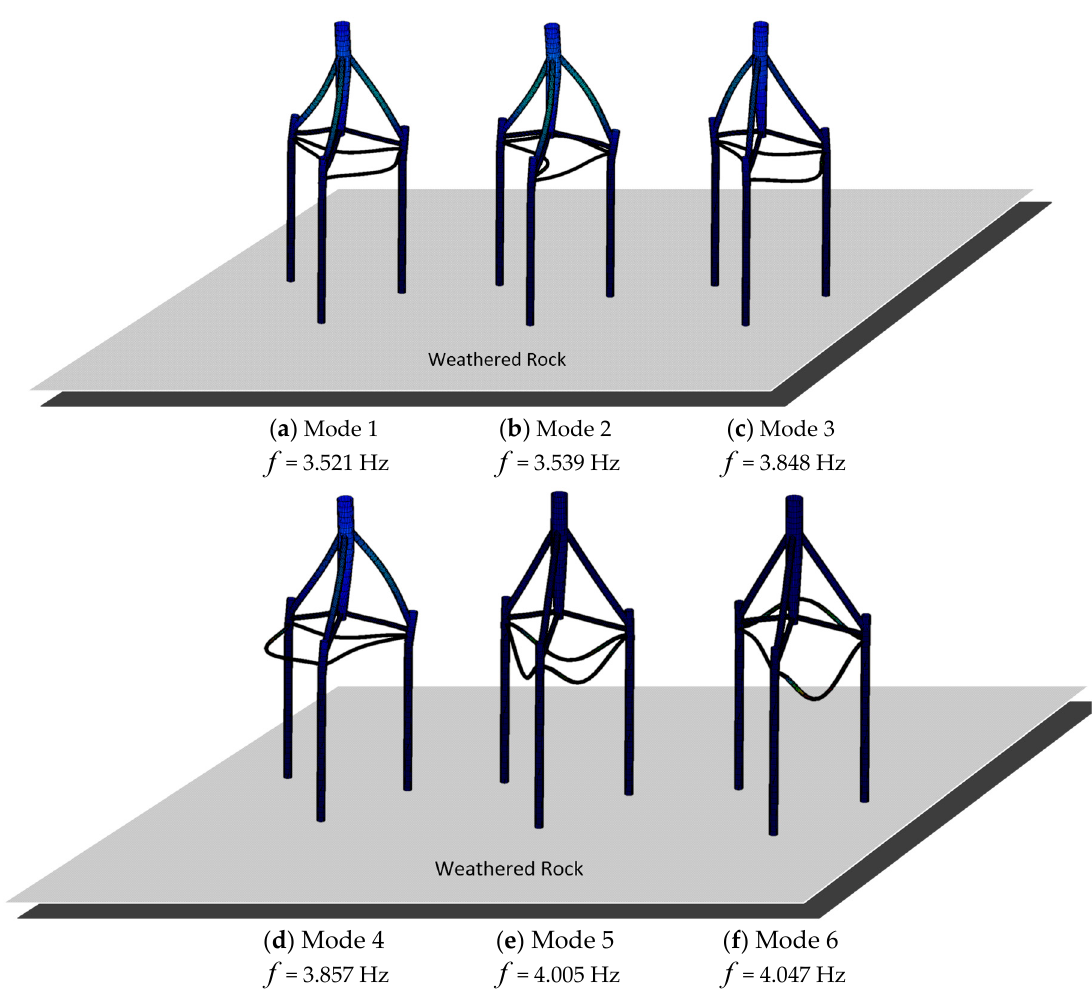
Figure 18. Natural frequencies and mode shapes resulting from the piled-supported structure model.